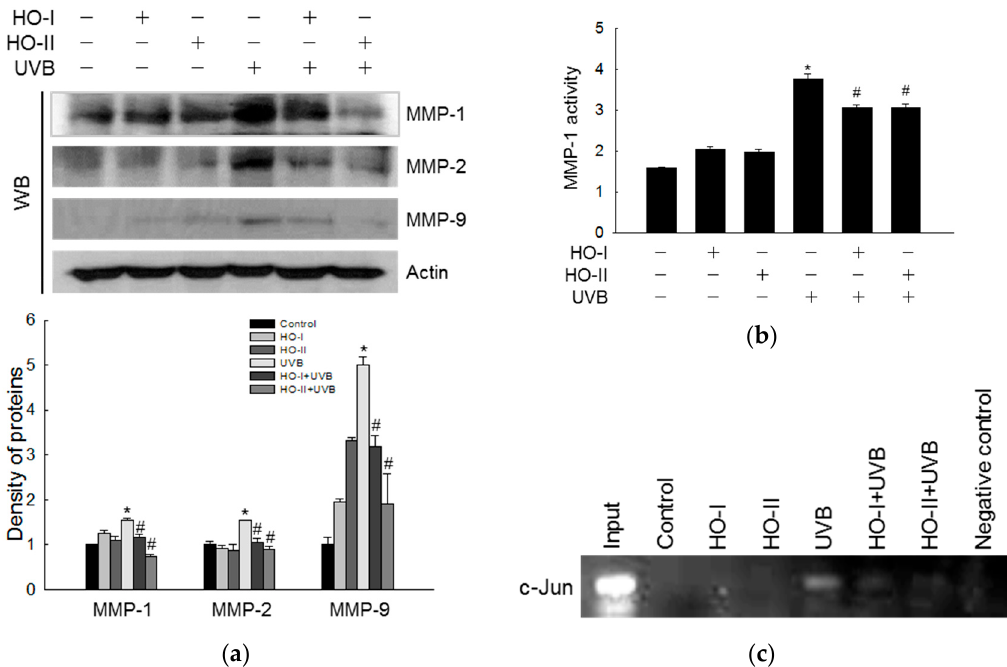
Figure 5. Horse oil reduces UVB-induced MMP expression and activation. ( a ) Western blot analysis of MMP-1, MMP-2, and MMP-9 protein expression and quantitative data are shown ( n = 3). ( b ) Active MMP-1 was quantified in the culture supernatants. Cells were incubated in serum-free medium to eliminate interference from MMP-1 in the serum. * p < 0.05 vs. control, and # p < 0.05 vs. UVB-irradiated cells. ( c ) AP-1 binding to the MMP-1 promoter was assessed by ChIP assay.